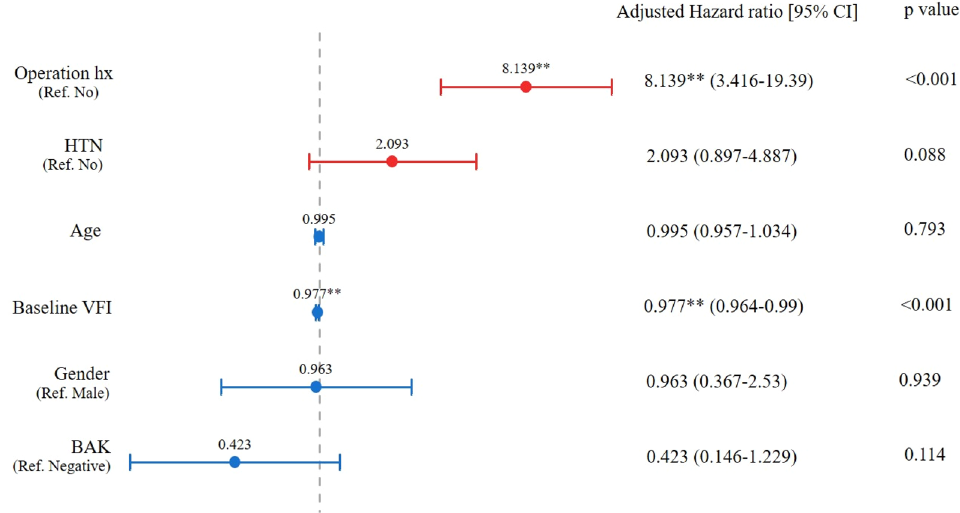
Figure 1. Cox proportional hazard analysis for the risk of periorbital dermatitis with topical dorzolamide- timolol (Operation hx; history of cataract surgery or glaucoma